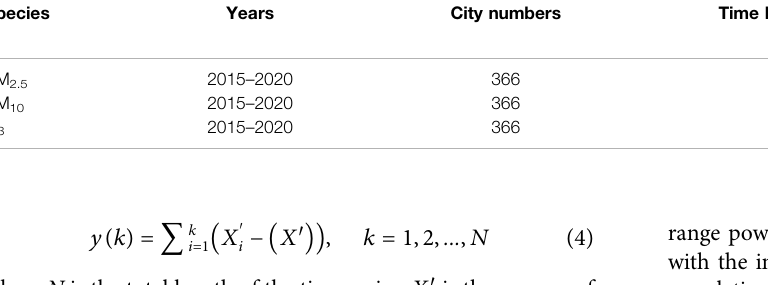
TABLE 1 | Summary of PM 2.5 , PM 10 , and O 3 concentration data.